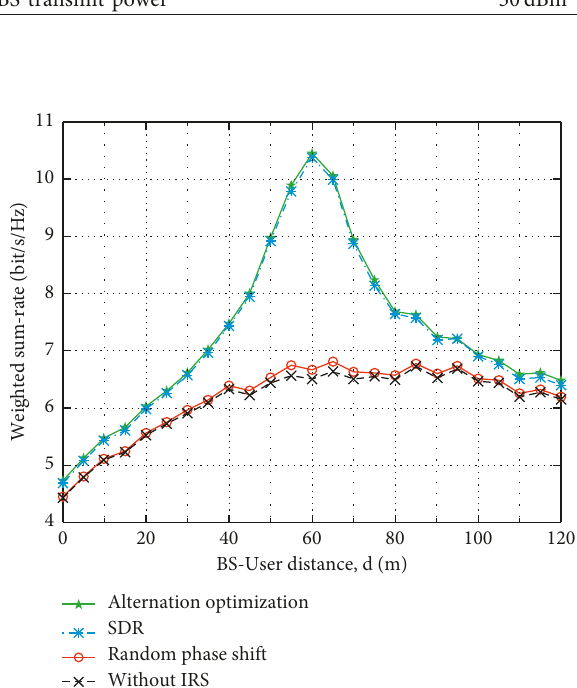
Figure 4: Change curve of achievable rate with distance.